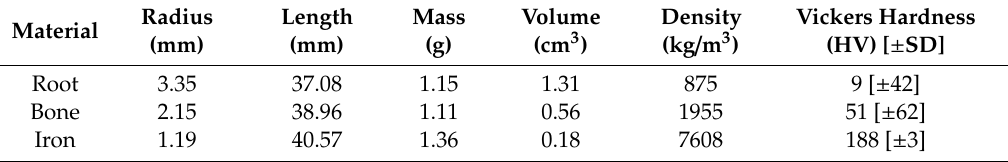
Table 1. Table showing the average geometrical and physical data for the composite